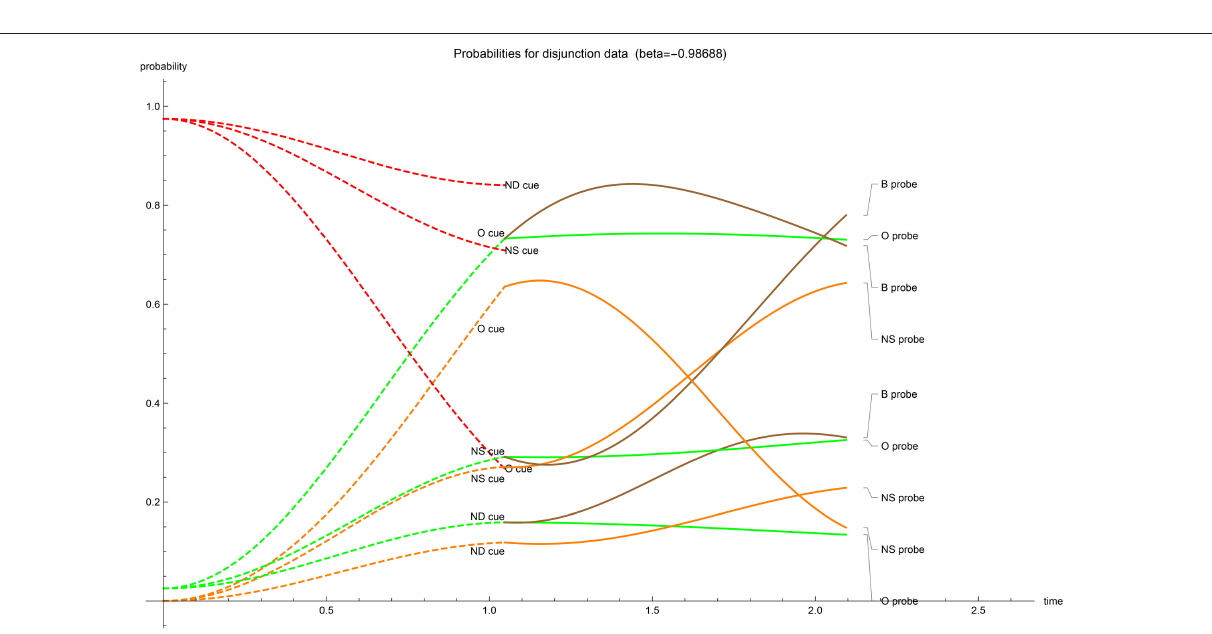
FIGURE 1 | β > 0 case: temporal evolution of acceptance probabilities for the EOD-disjunction paradigm [3]. Red indicates N probability component, orange indicates G probability component and green indicates V G probability component. In the second stage brown indicates the acceptance probability for the b ? probe + G ). Notice the near absence of verbatim in the initial state. ( V +